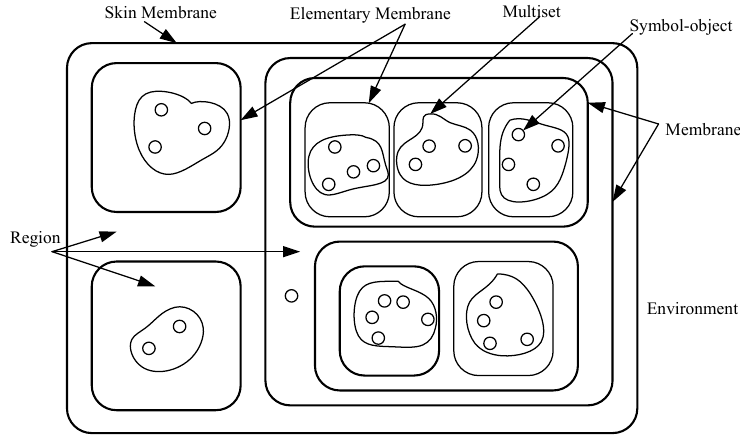
Figure 2. A membrane computational